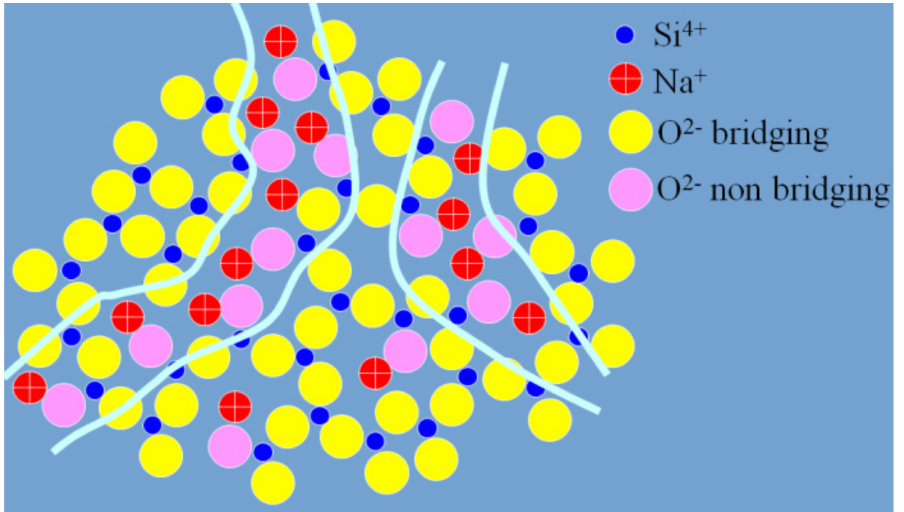
Figure 1. Schematic of modified random network (MRN) model of sodium–silicate glass with percolation ionic channels formed by alkali cations associated with non-bridging oxygens (NBOs). Ionic radii are as follows: r(Si 4+ ) = 54 pm, r(Na + ) = 116 pm, r(O 2- ) = 126 pm. The regions comprised of large concentrations of network modifiers so that alkalis form ionic percolating channels at higher concentrations—in silicate glasses typically at <67 mol.% of silica, whereas at higher content of silica, these regions are isolated from each other by the silica skeleton (network regions). The SiO 4 tetrahedra define the network regions, while non-bridging oxygen (NBO) atoms define depolymerized regions that can form percolation channels. The percolation ionic channels are defined by the NBO atoms at the edges of the highly ordered network regions, which ionically bond to the alkali, alkaline earths, or other modifier species in a